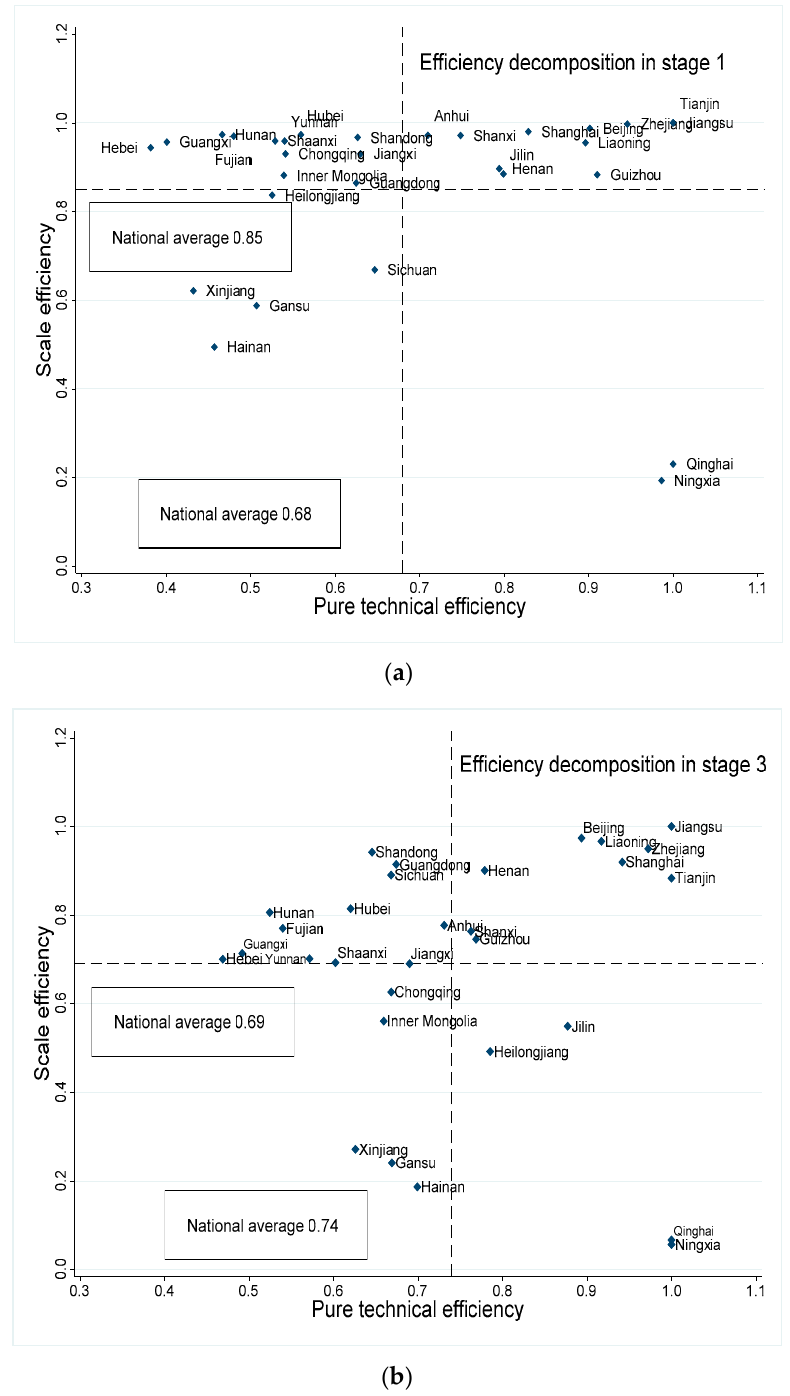
Figure 6. Categorization of PTE and SE of 30 provinces. ( a ) PTE and SE in Stage 1; ( b ) PTE and SE in Stage 3.